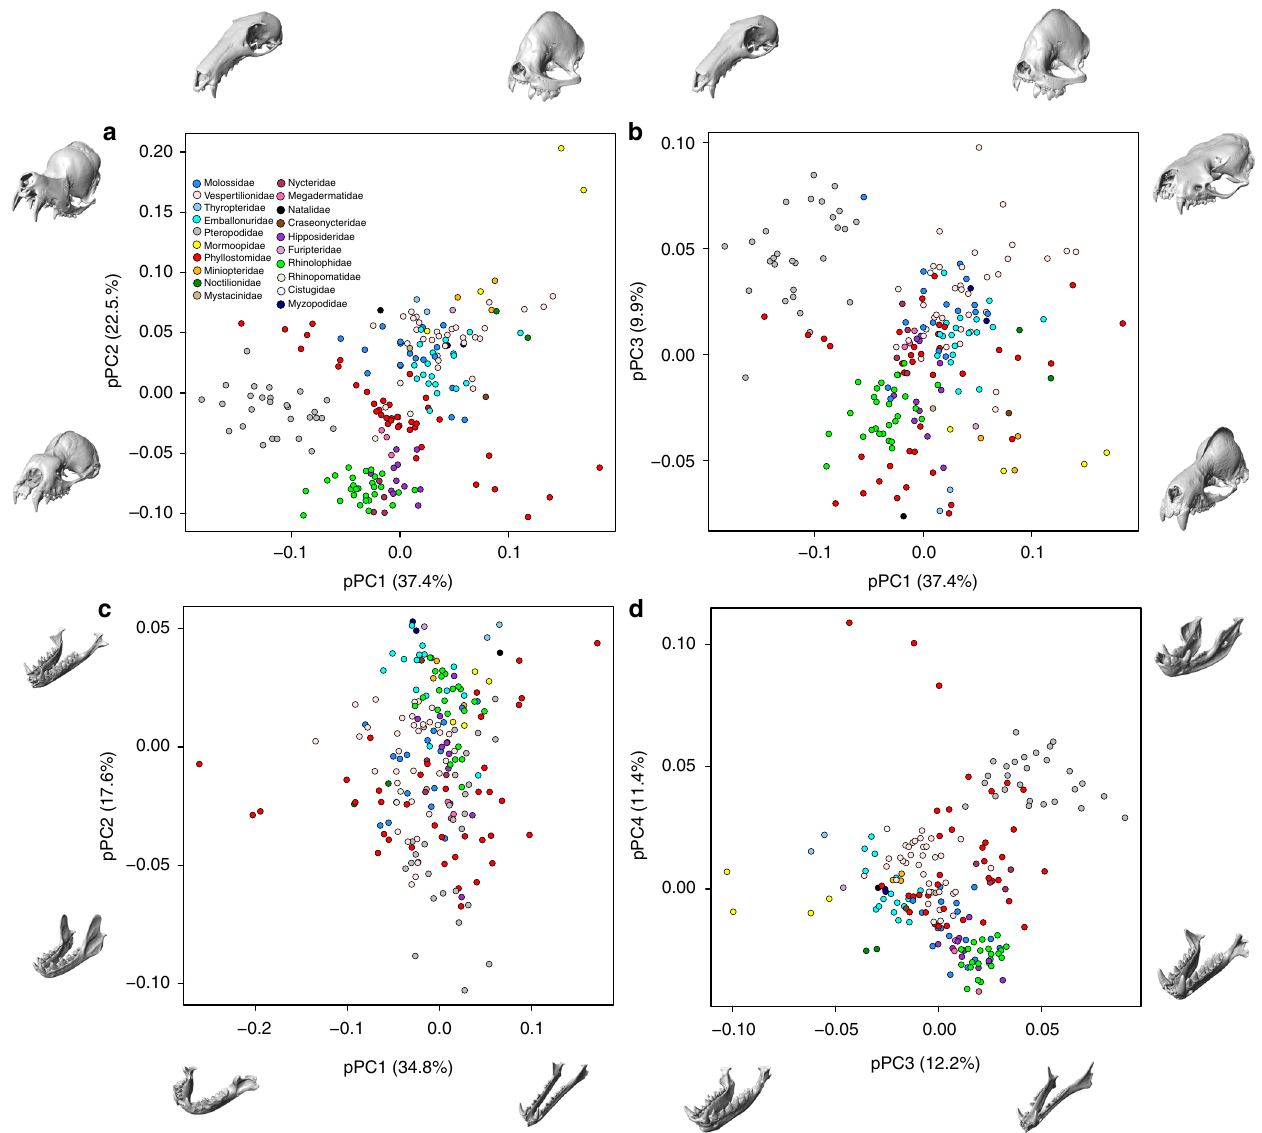
Fig. 1 Cranial and mandibular morphospaces of bats based on phylogenetic PCA. Digital models of crania and mandibles from μ CT data illustrate the trends across each axis, 3D models visualized using Checkpoint. Taxa illustrated: Cranium ( a , b ) — pPC1 ( + Centurio senex , − Macroglossus sobrinus ), pPC2 ( + Mormoops blainvillei , − Hipposideros caffer ), pPC3 ( + Tylonycteris robustula , − Lophostoma silvicolum ); Mandible ( c , d ) — pPC1 ( + Choeronycteris mexicanus , − Centurio senex ), pPC2 ( + Myzopoda aurita , − Dobsonia praedatrix ), pPC3 ( + Macroglossus sobrinus , − Mormoops megalophylla ), pPC4 ( + Desmodus rotundus , − Megaderma spasma ). Percent values give the R 2 from a Procrustes multiple regression of landmark coordinates on pPC scores, see Methods and source data fi